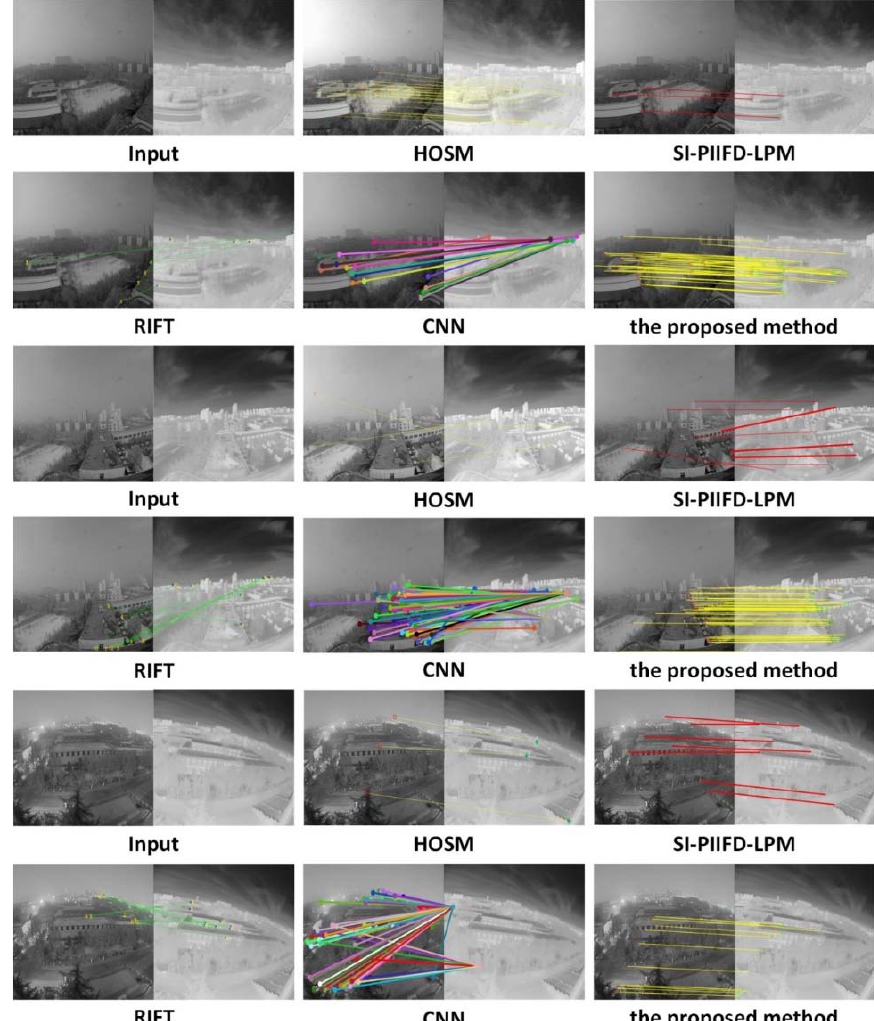
Figure 10. Feature extraction results, of the algorithm in this paper, in four pairs of images.